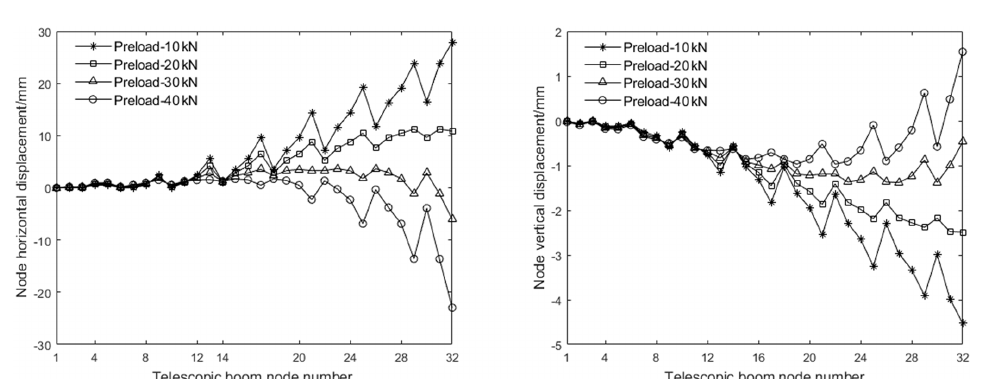
Figure 15. Telescopic boom node number.